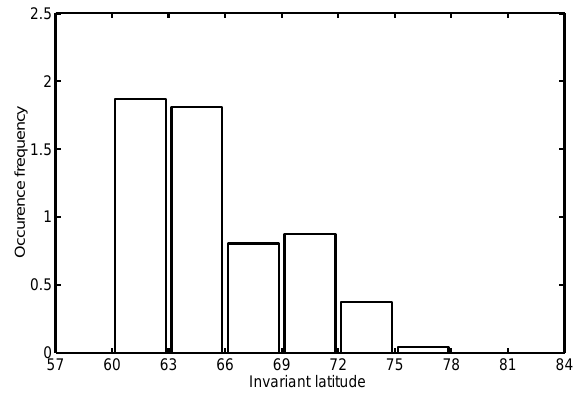
Fig. 4. Distribution of the invariant latitude of the identified Viking LHCs. The normalisation used here is the number of LHCs found per five minutes in the latitude range of interest. Five minutes typi- cally corresponds to about 1000km along the satellite path.